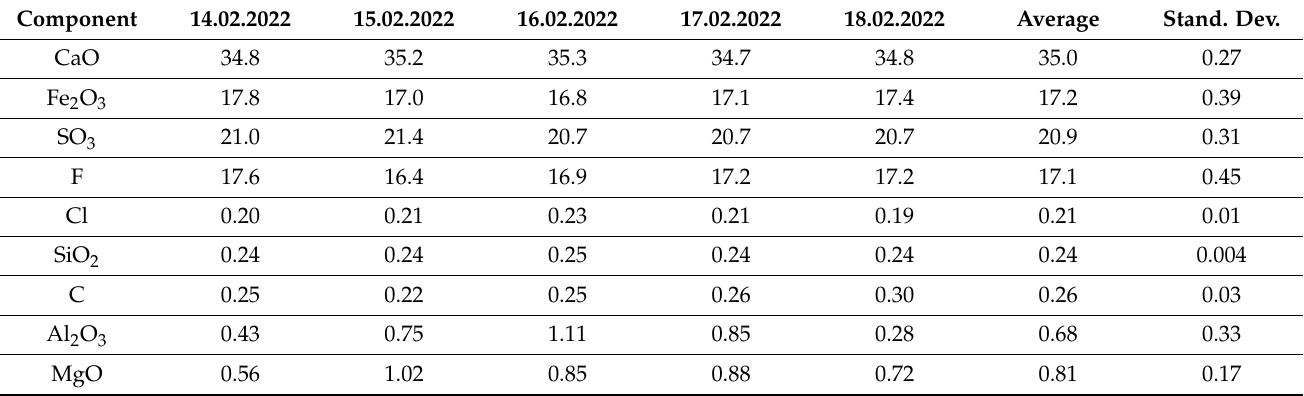
Table 2. Chemical analysis of the previously dried samples obtained by XRF